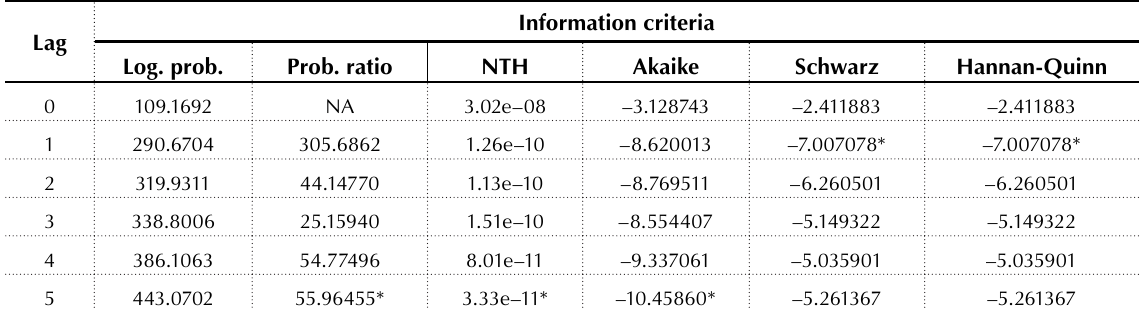
Table 3. Lag interval tests